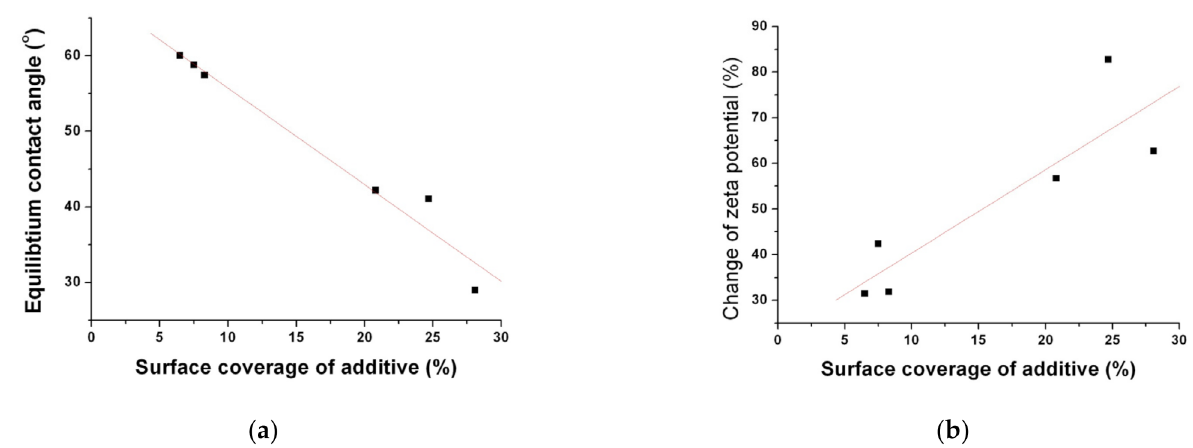
Figure 8. The relationships ( a ) between the surface coverage (%) of the additive and the equilibrium contact angle and ( b ) between the surface coverage (%) of the additive and the % change of the zeta